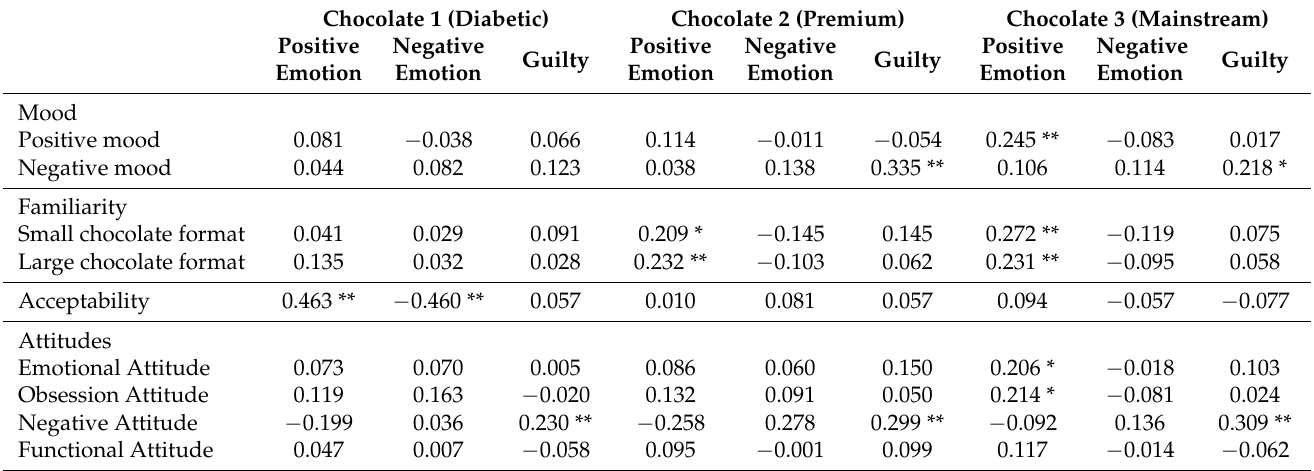
Table 3. Correlations between consumer behaviour variables and emotional response of three